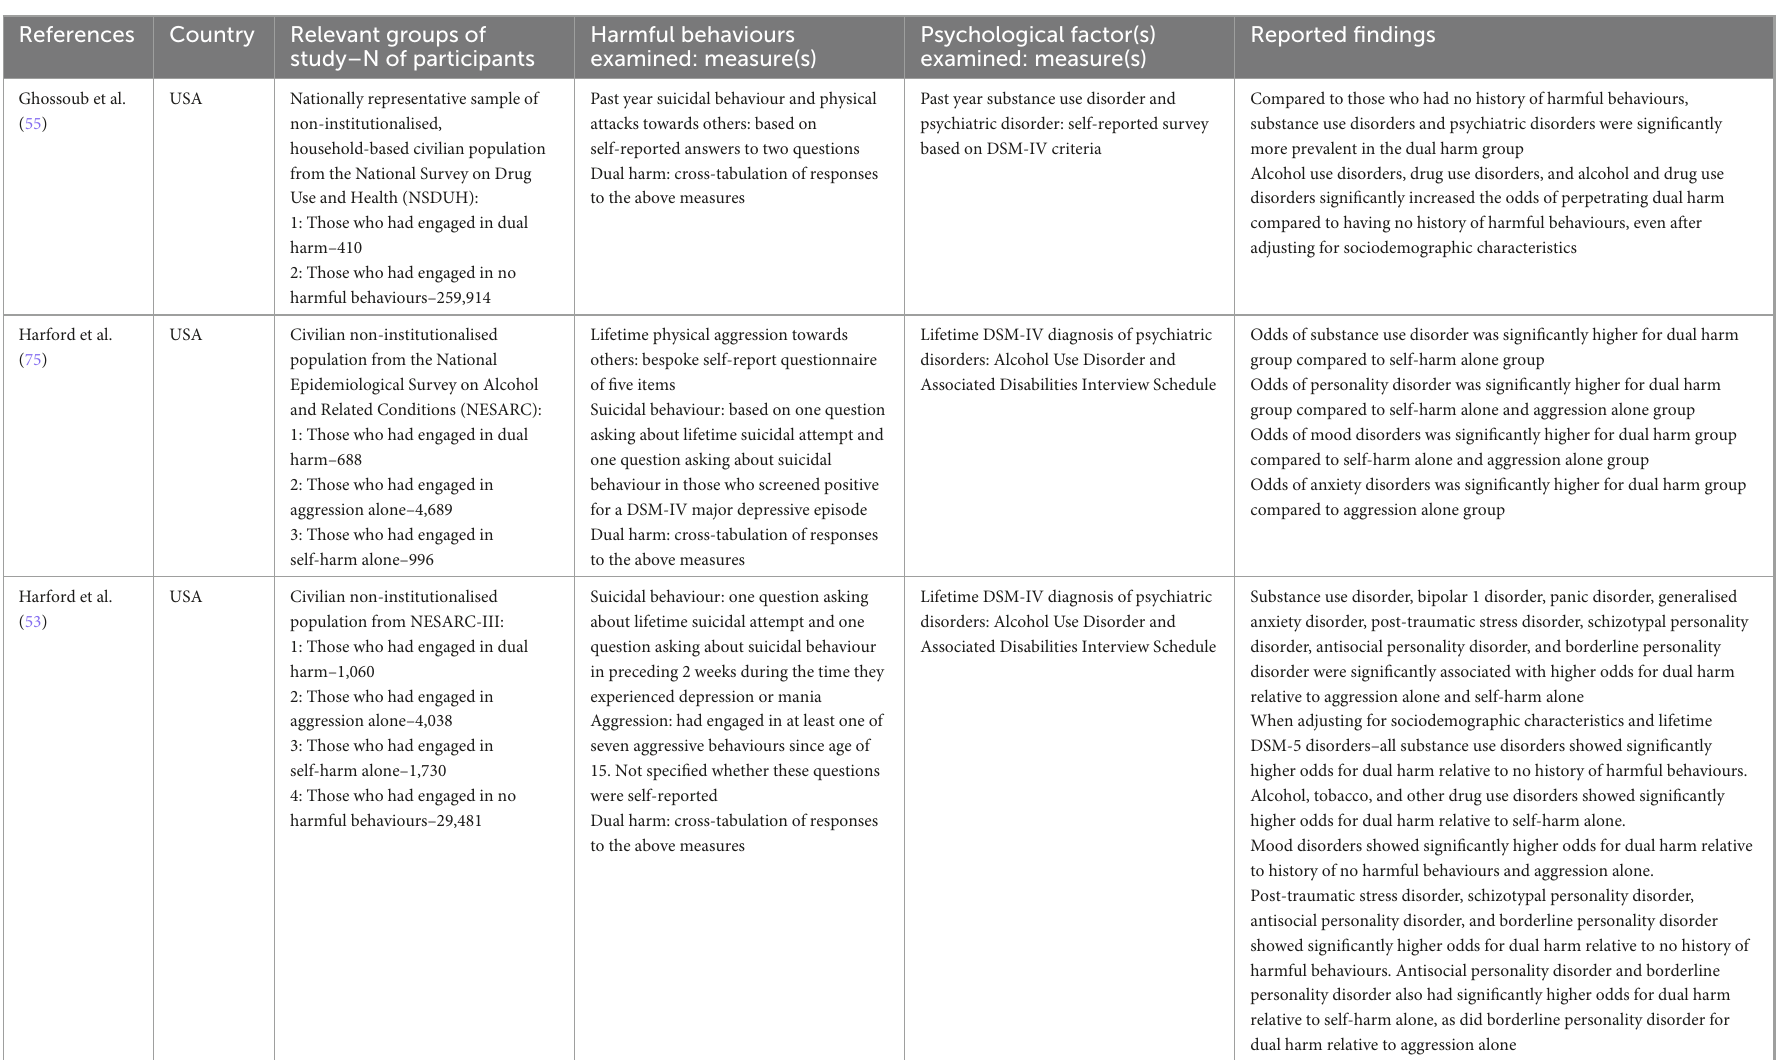
TABLE 3 Summary characteristics of non-homicide-suicide